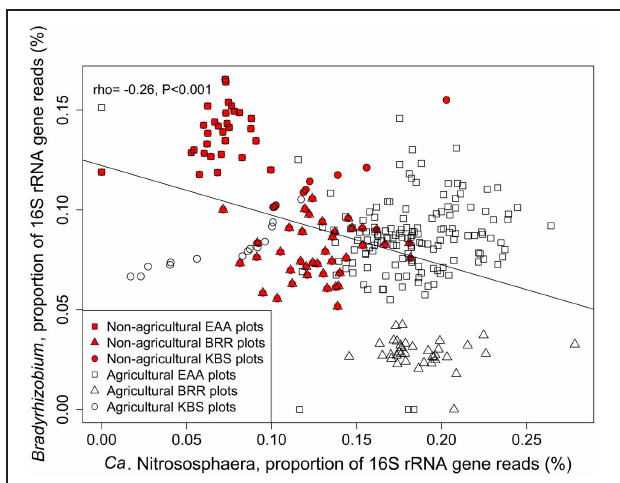
FIGURE 2 | Proportionof 16S rRNA gene reads of Ca. Nitrososphaera and Bradyrhizobium at Rothamsted Research (BRR), the Everglades Agricultural Area (EAA) and the Kellogg Biological Station (KBS). Proportion of 16S rRNA reads was normalized by arcsine square root.